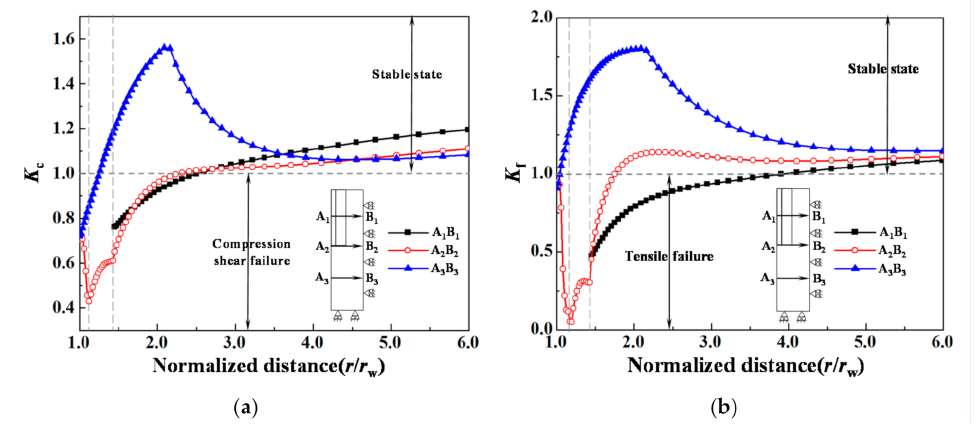
Figure 10. Comparison of the wellbore collapse coefficients and rupture coefficients of the three sections: ( a ) wellbore collapse coefficients; ( b ) rupture coefficients